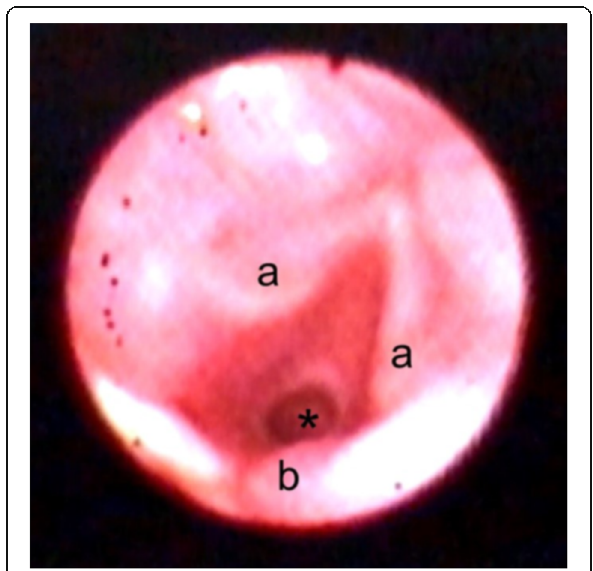
Fig. 2 Subglottic stenosis was observed using fiberoptic bronchoscopy. Subglottic stenosis (*), vocal cords (a), corniculate cartilage